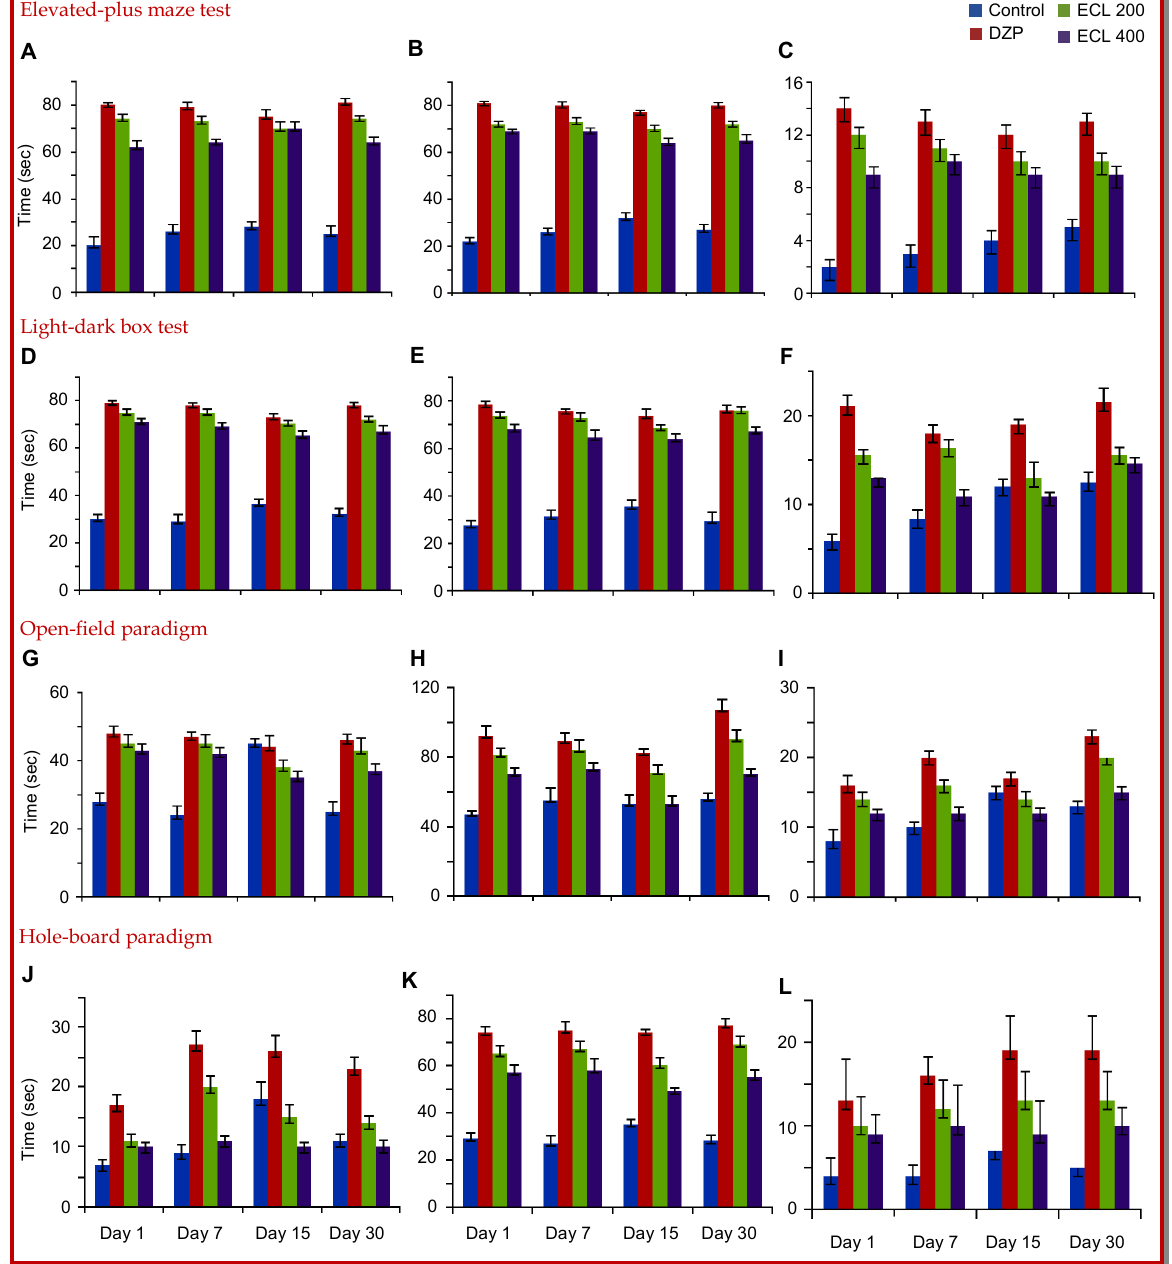
Figure 1: Effect of Cocculus laurifolius extract on A) percentage entries in open arm, B) percentage time spent in open arm and C) total number of rearing in elevated-plus maze test; Effect of Cocculus laurifolius extract on D) percentage number of entries, E) per- centage time spent and F) total number of rearing in light area in light-dark box test; Effect of Cocculus laurifolius extract on G) number of center square crossed, (H) number of peripheral square crossed and I) number of total number of rearing in open-field paradigm; Effect of Cocculus laurifolius extract on J) latency to first head dip, K) number of head dips and L) total number of rear- ing in hole-board paradigm; Data expressed as mean ± SEM;